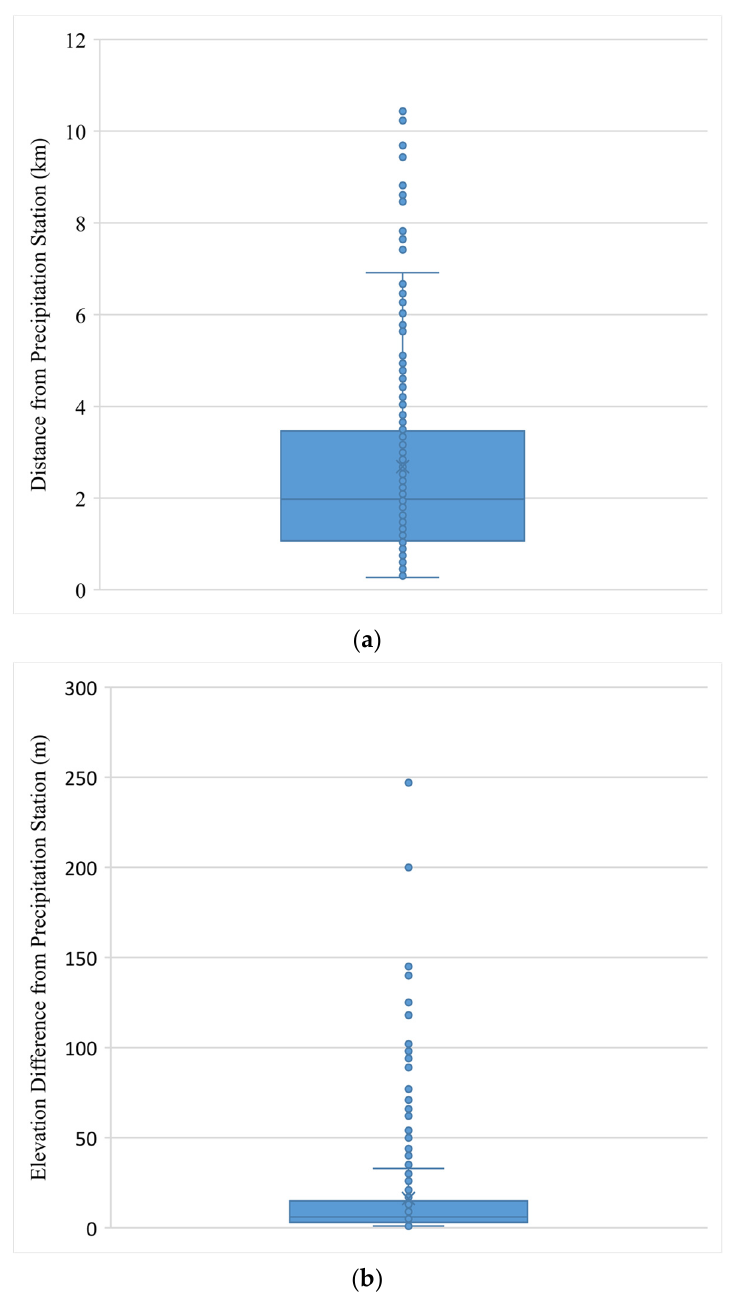
Figure 6. Distances (km) ( a ) and differences in elevation (m) ( b ) of stations measuring temperature, wind speed and dew point from their corresponding station measuring precipitation, for the 1058 out of 2090 stations where these variables are measured at different locations.